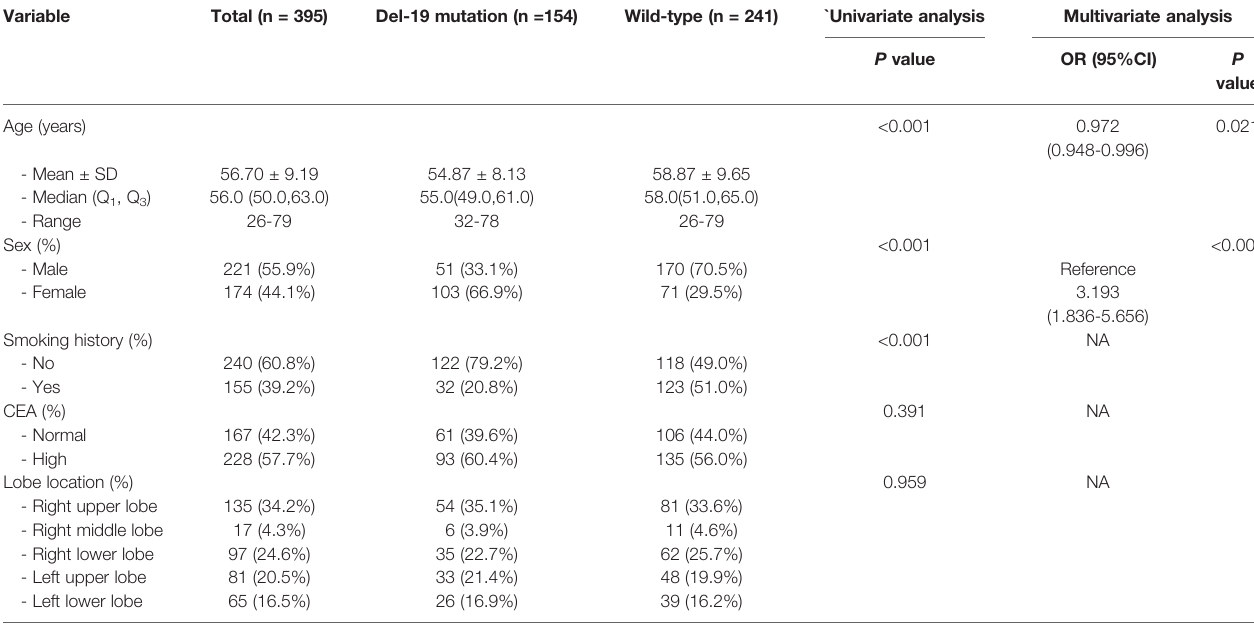
TABLE 1 | The relationship between clinical variables of patients and EGFR molecular subtypes (Del-19 mutation vs. Wild-type) in the training set. Variable